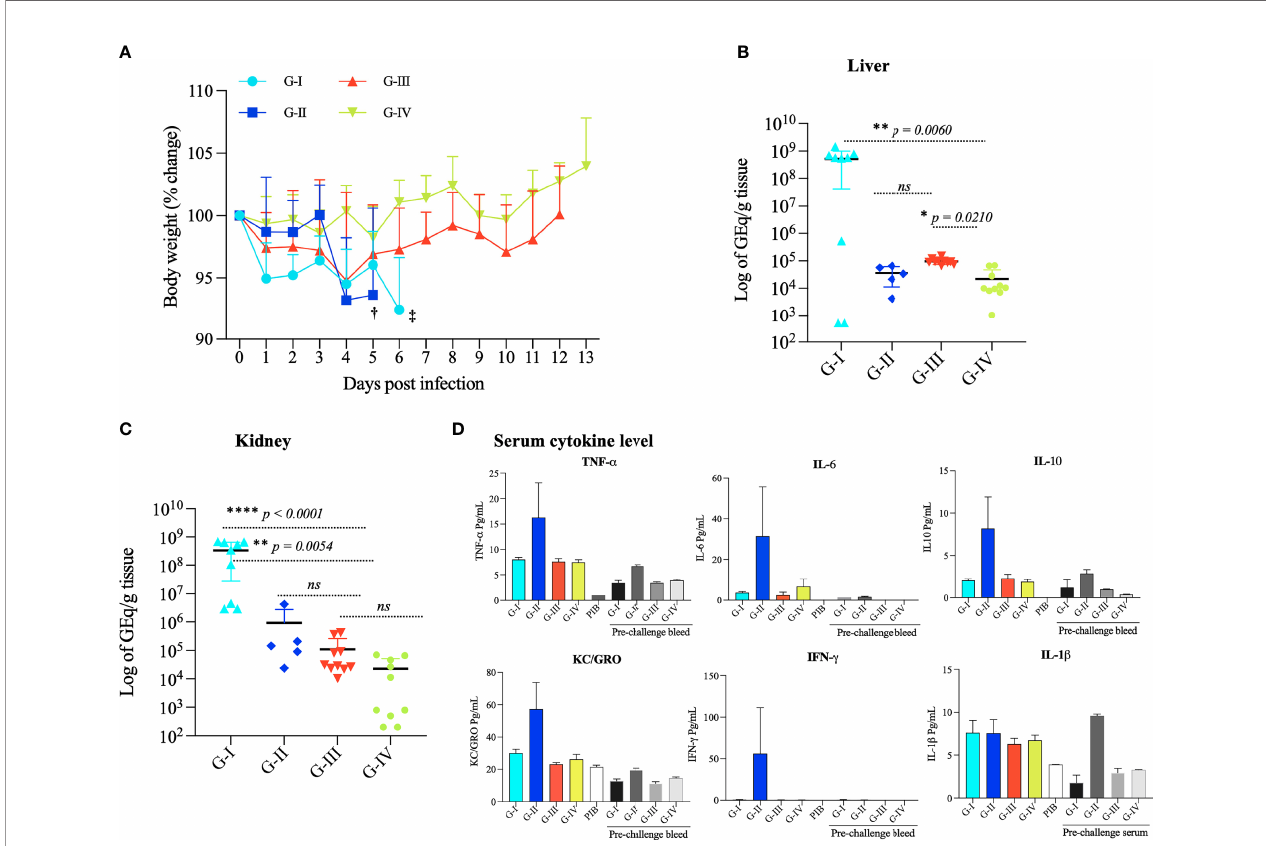
FIGURE 3 | Body weight change, bacterial load, and pro-in fl ammatory cytokine response of mice challenged with L. interrogans serovar Canicola. (A) Mouse body weight (% change) was recorded from 0 day to 13 days upon infection; concurrent assessment of clinical status (grooming, eating, drinking, energy level) was also observed. G-I and G-II mice were sacri fi ced at 6 th and 5 th day ( ‡ and † ,). Statistical analysis was performed to determine statistical signi fi cance in body weight between the PBS control and vaccinated groups using two-tailed unpaired, Mann-Whitney T-Test. p values: VM mix vs PBS, p - 0.0152 * : VM unlabeled vs PBS, p – 0.0005* : VM unlabeled vs VM mix, p < 0.0001 ****: t3490 vs PBS, p - 0.3869, ns. Error bars indicate the standard error. Total genomic DNA was extracted from the kidney (B) and liver (C) and analyzed by qPCR performed in duplicates with lipL32 primers and SYBER Green probes to quantify leptospiral tissue load.